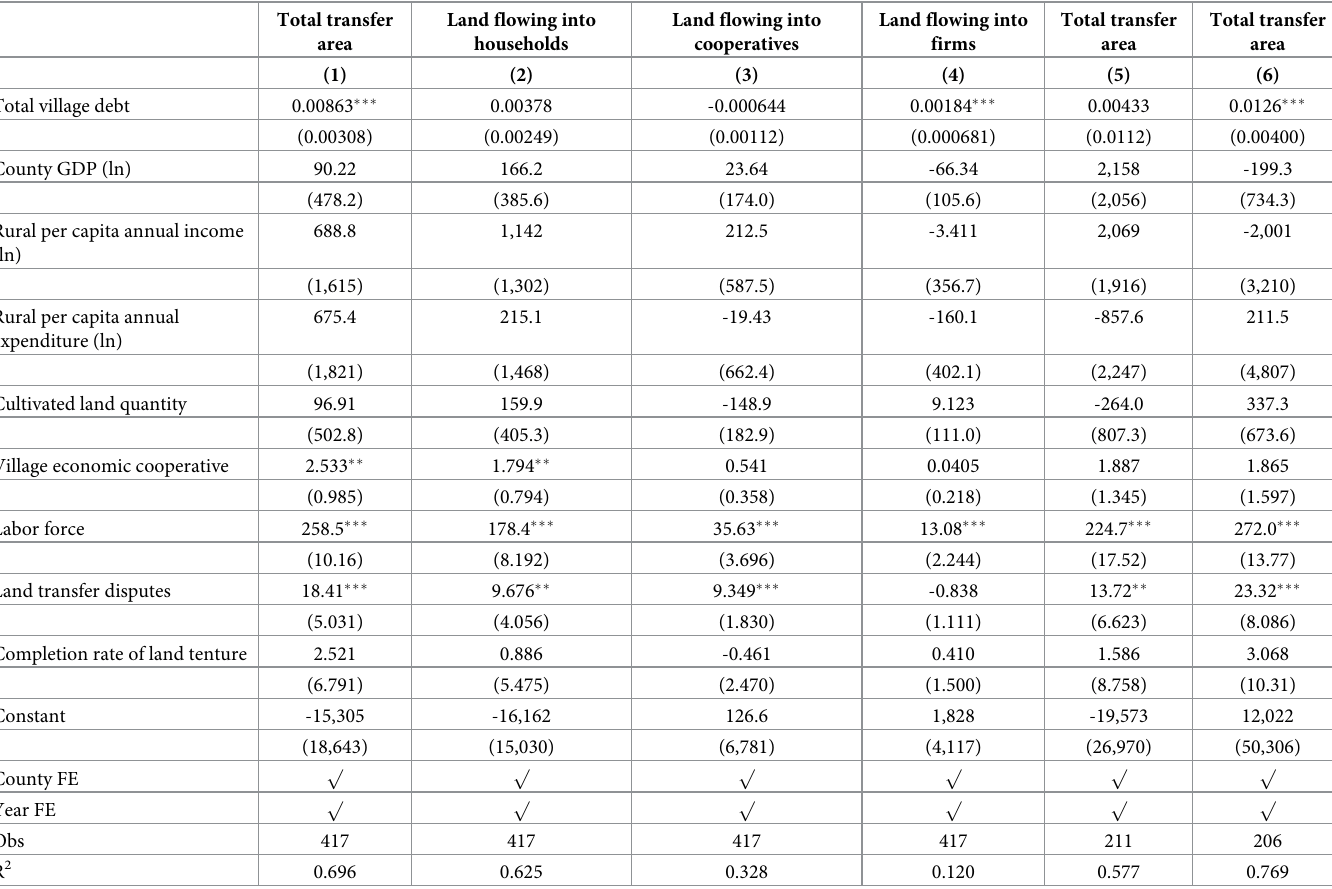
Table 3. The estimation results of the relationship between village-level debt and rural land